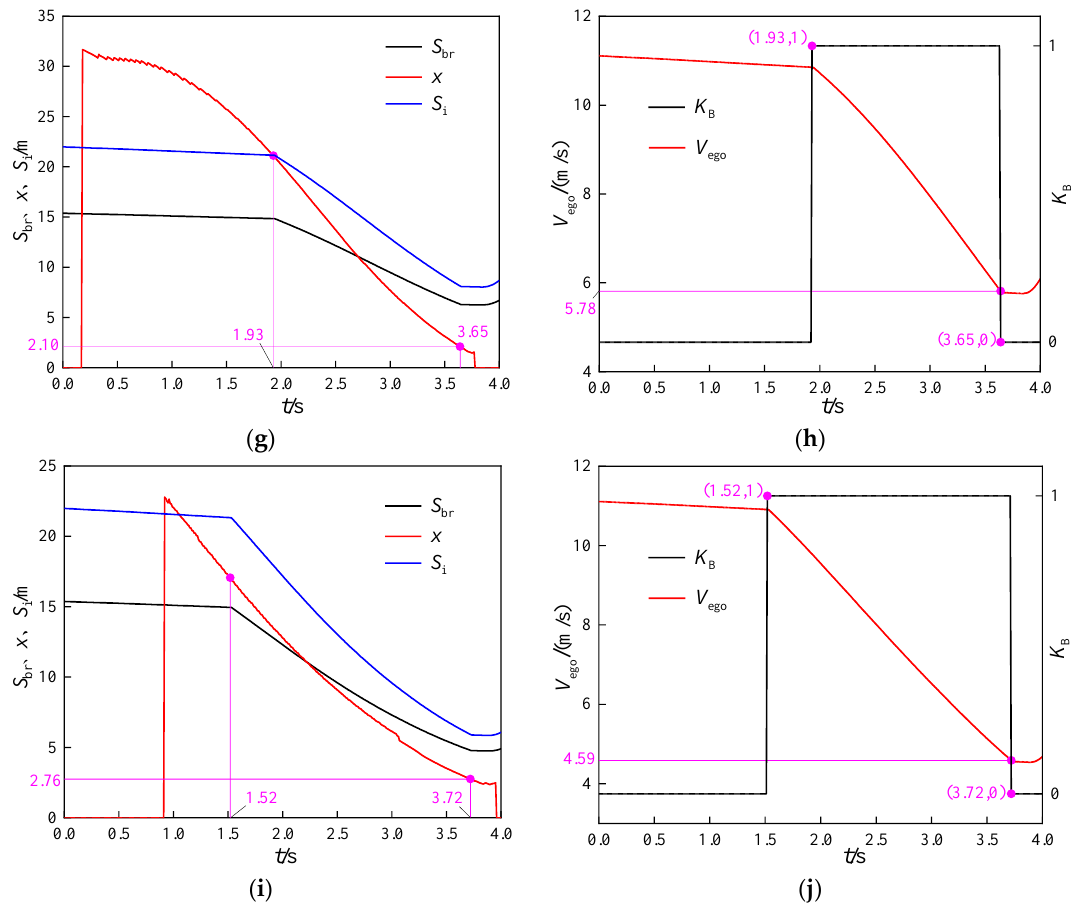
x , and S , S in scenario 2. b r i